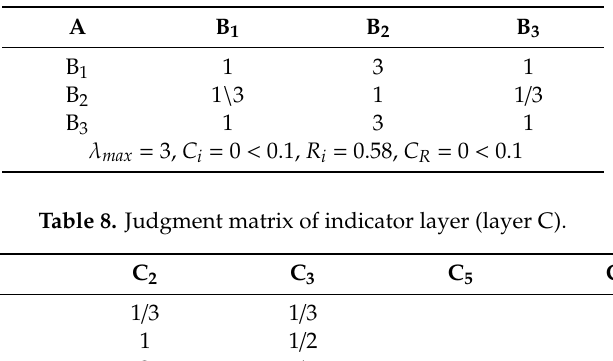
Table 7. Judgment matrix of the criteria layer (layer B).